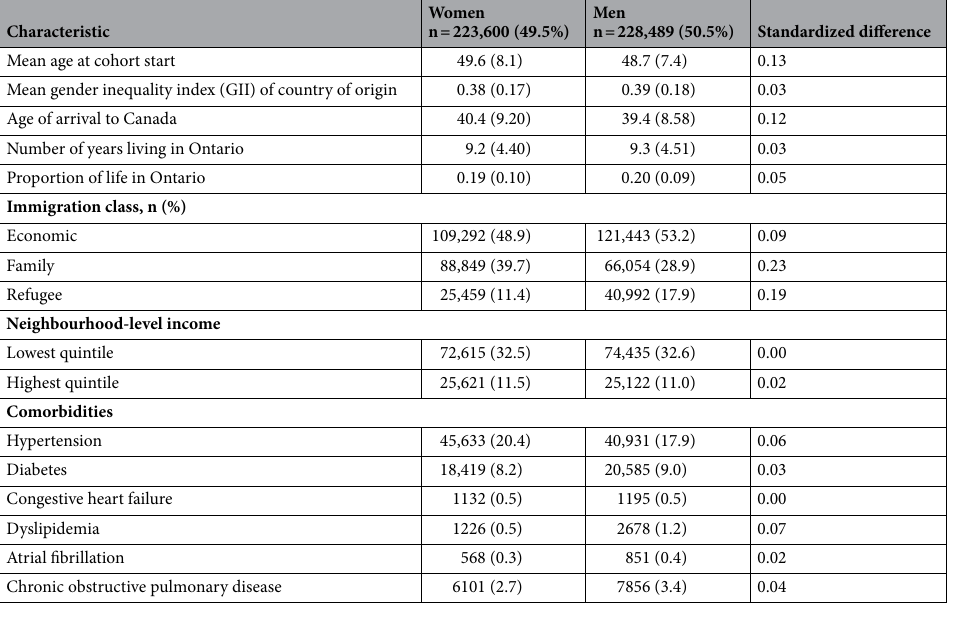
Table 1. Characteristics of adult immigrants (aged 40–69 years) residing in Ontario, Canada as of cohort start date, January 1, 2003 (N =